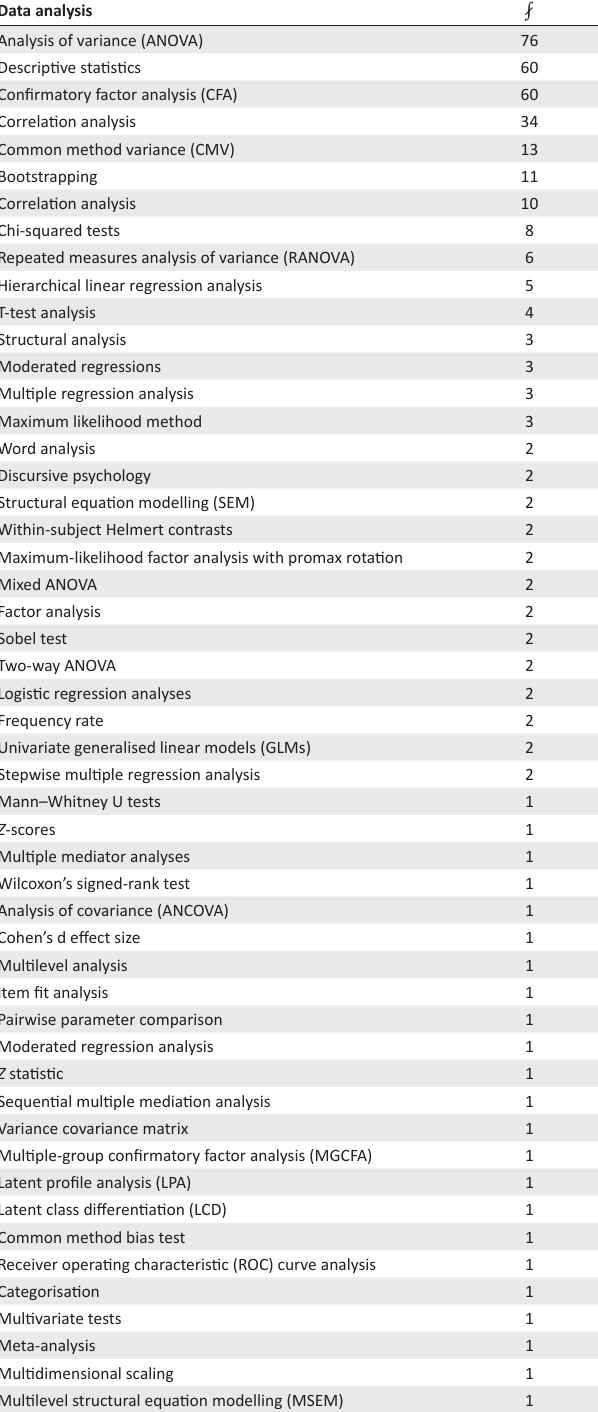
TABLE 6: Data analysis in sample